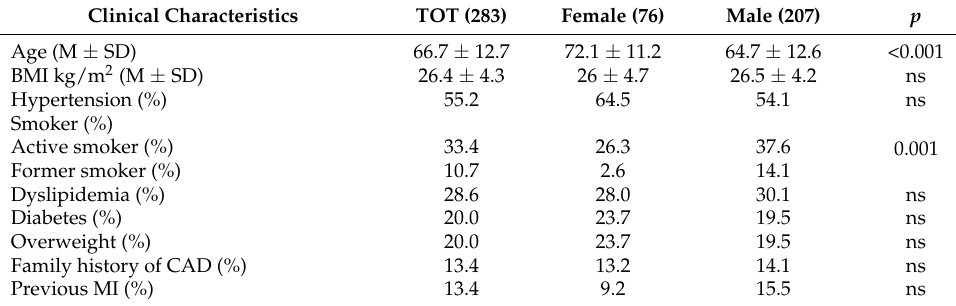
Table 1. Clinical characteristics of the